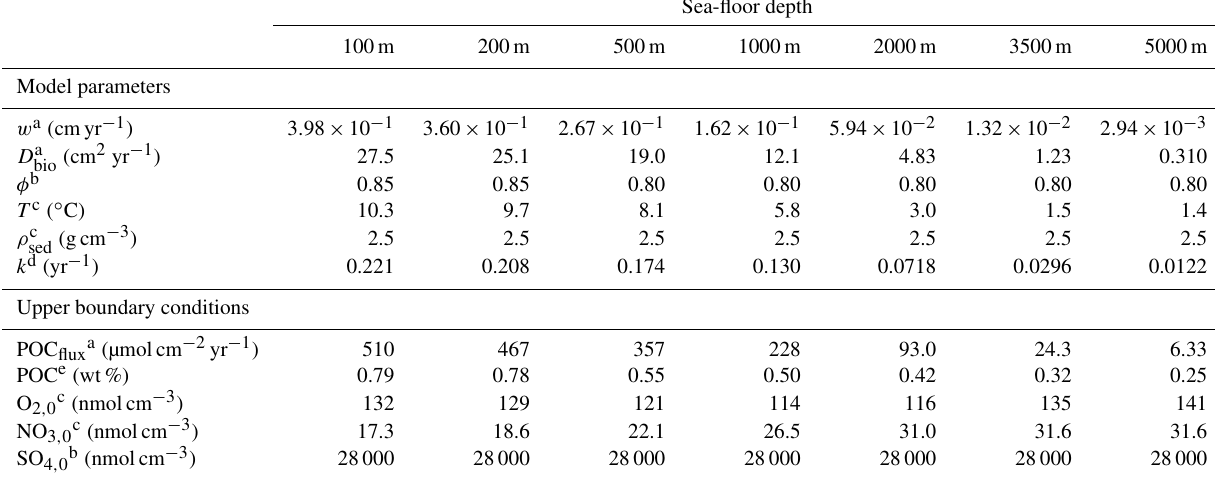
Sea-floor depth